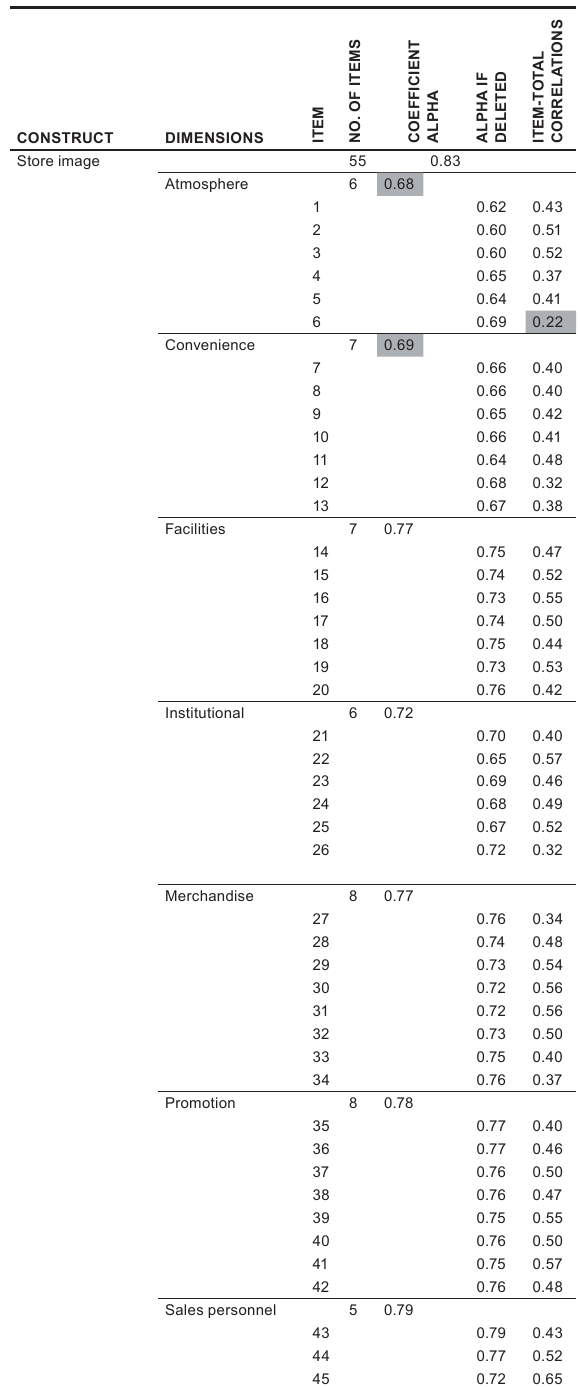
TABLE 2 Reliability and item-total correlations – Mall intercept